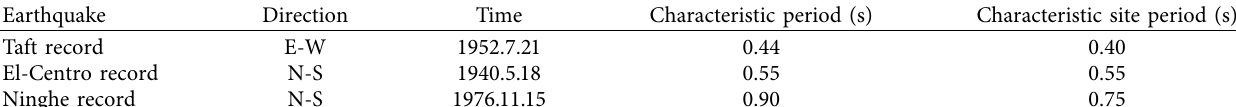
Table 3: Earthquake records and characteristic site period.